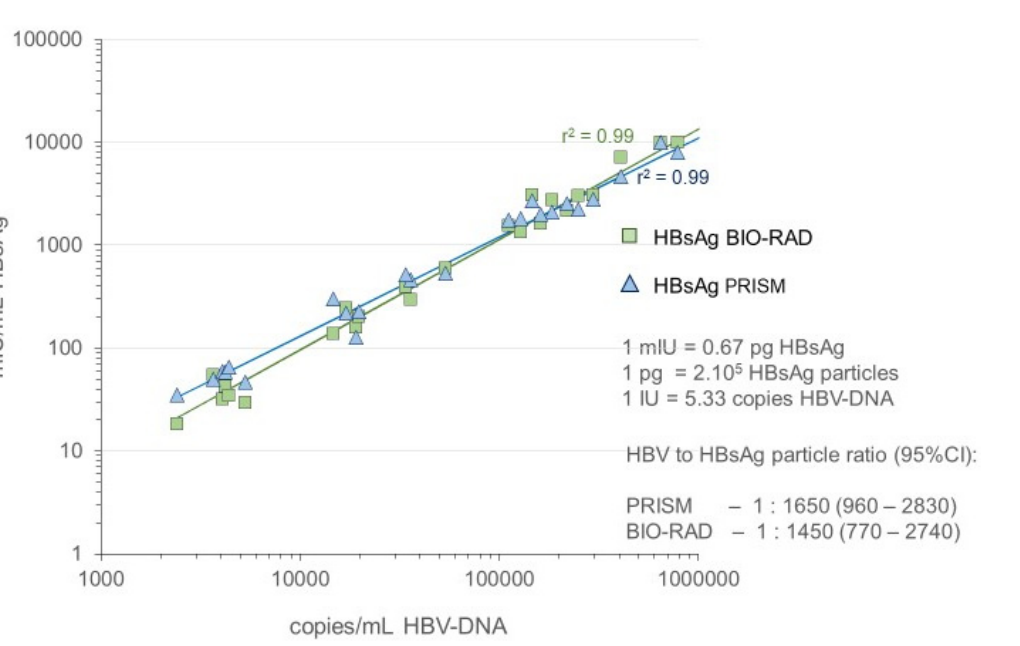
Figure 3. Parallel increase of Log HBV ‐ DNA (bDNA 3.0 assay) and Log HBsAg concentration (PRISM and BIO ‐ RAD assays) during ramp ‐ up phase of viremia in seroconverting plasma donors (seroconversion panels #6284, #6289, #6292, and #11008).